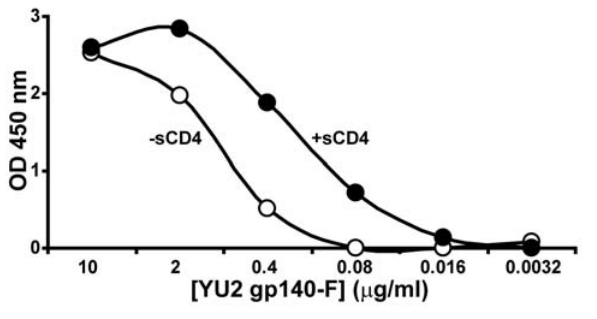
Figure 2. ELISA analysis of the 17b:trimer interaction. The YU2 gp140-F trimers, at concentrations of 3.2 ng/ml to 10 m g/ml, were incubated in the presence (closed circles) or absence (filled circles) of 20 m g/ml sCD4, after which recognition of the trimers by the co- receptor-binding-site-directed antibody, 17b, was analyzed by ELISA. Because of the oligomeric state of the trimers, this assay likely assesses binding avidity, however, the precise stoichiometry of CD4 occupancy of each trimer or the functional ability of each gp120 subunit within the trimer to bind CD4 is not yet known. The addition of sCD4 to the trimers resulted in an approximate 5-fold shift in the levels of K maximal binding, from 9 nM, in the absence of CD4, to 2 nM in the presence of CD4.